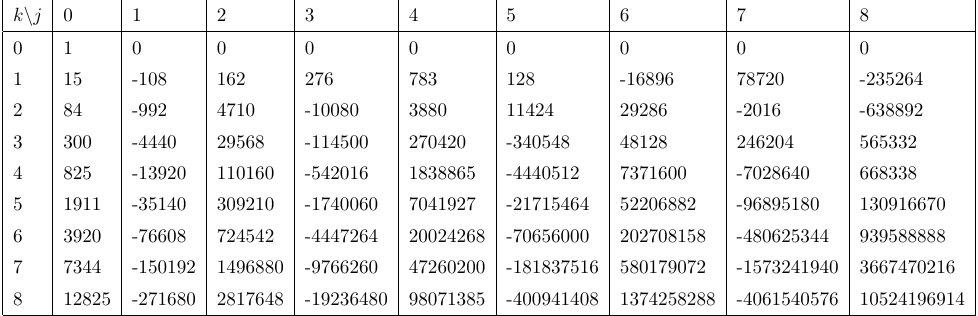
Table 28. Table of b jk coe(cid:14)cients for h SU(4)